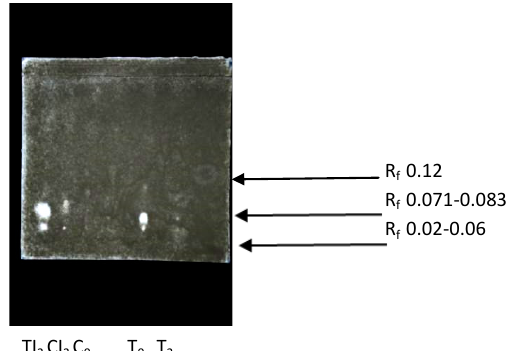
Table 5: Effect of Silicon soil drench treatment on the number, fresh weight, length and diameter ratio of chili pepper, cv. HYW. Control Treated Fruit number 42 * 47 a Fresh weight (g) 66 a 58 a Fruit Diameter: Length 1.10 a 1.13 a *Pairwise mean values, followed by the same letters for yield parameters among treatments, are not significantly different according to Duncan’s multiple ranger test (p<0.05). DR- Disease Reduction.